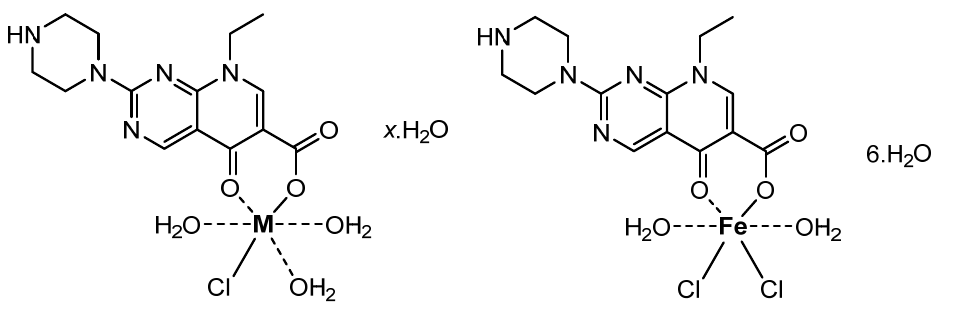
Figure 2. Suggested structures of pipemidic acid (pip)–magnesium, calcium, zinc, and iron (III) drug complexes (M = Mg II (x = 6), Ca II (x = 2), and Zn II (x = 4)).